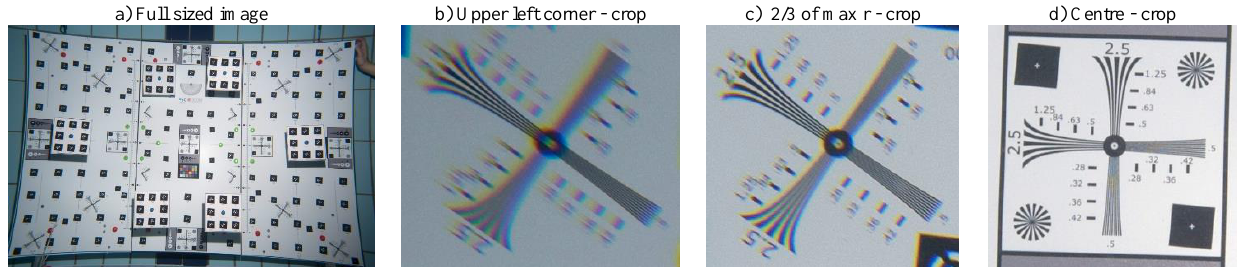
Figure 1. An image of the rectangular calibration object as described in (Menna et al., 2017) showing curvilinear pincushion distortion (a) Crops of the resolution patches respectively at upper left corner (b), 2/3 of max r (c) and at centre